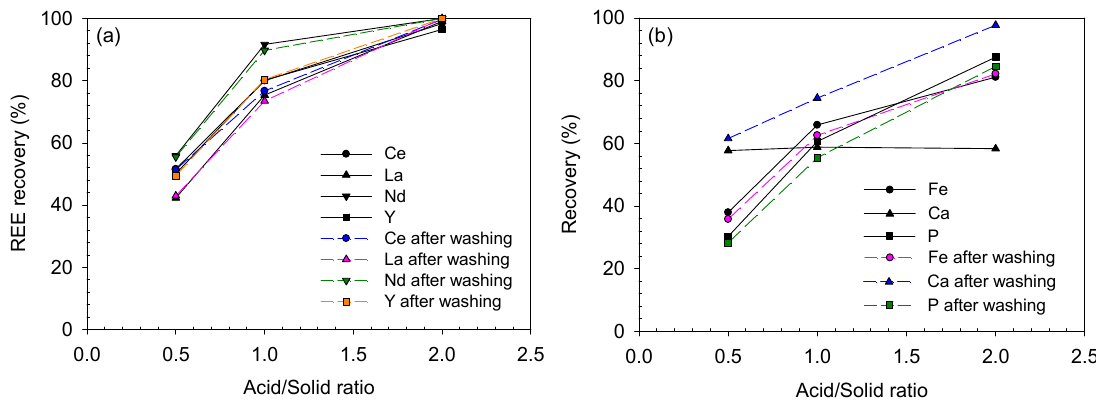
Figure 10. Leaching recoveries of ( a ) REEs and ( b ) impurities after water-leaching of the baked ore at different acid/solid ratios of sulfuric acid baking (baked at 200 °C for 2 h and leached at 25 °C for 3 h) .